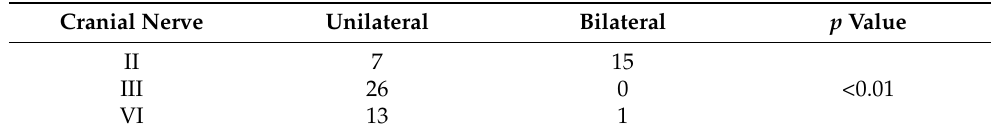
Table 2. Cranial Nerve Deficits at Presentation.